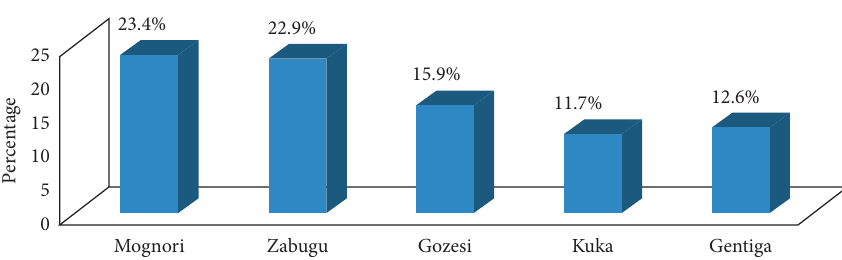
Figure 11: Respondents view on the effect of temperature variability on crop